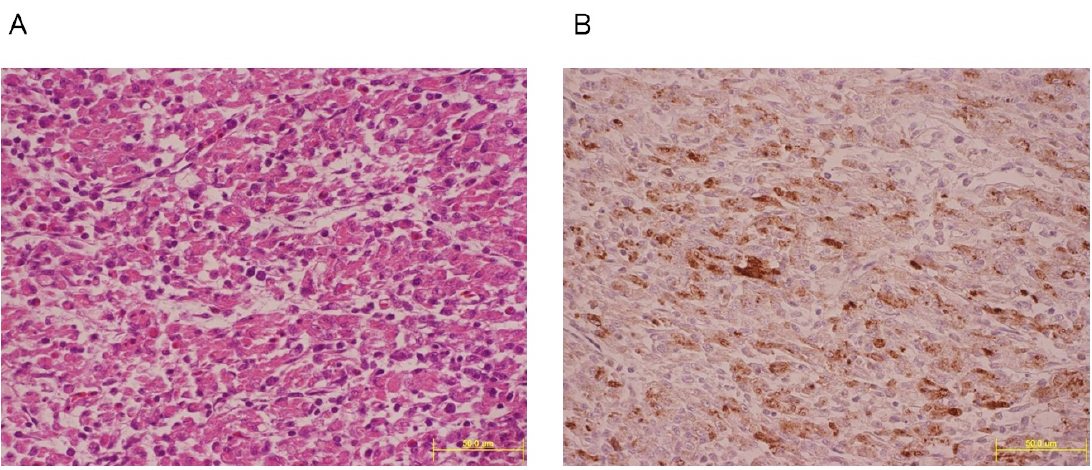
Figure 2. Histopathological and immunohistochemical findings of the 6-LP infected young chicks. ( A ) Photomicrograph of marked necrosis of myocytes of heart from a young chick with WN virus infection. HE stain. ( B ) Myocytes of heart are positively stained for WN virus antigen.